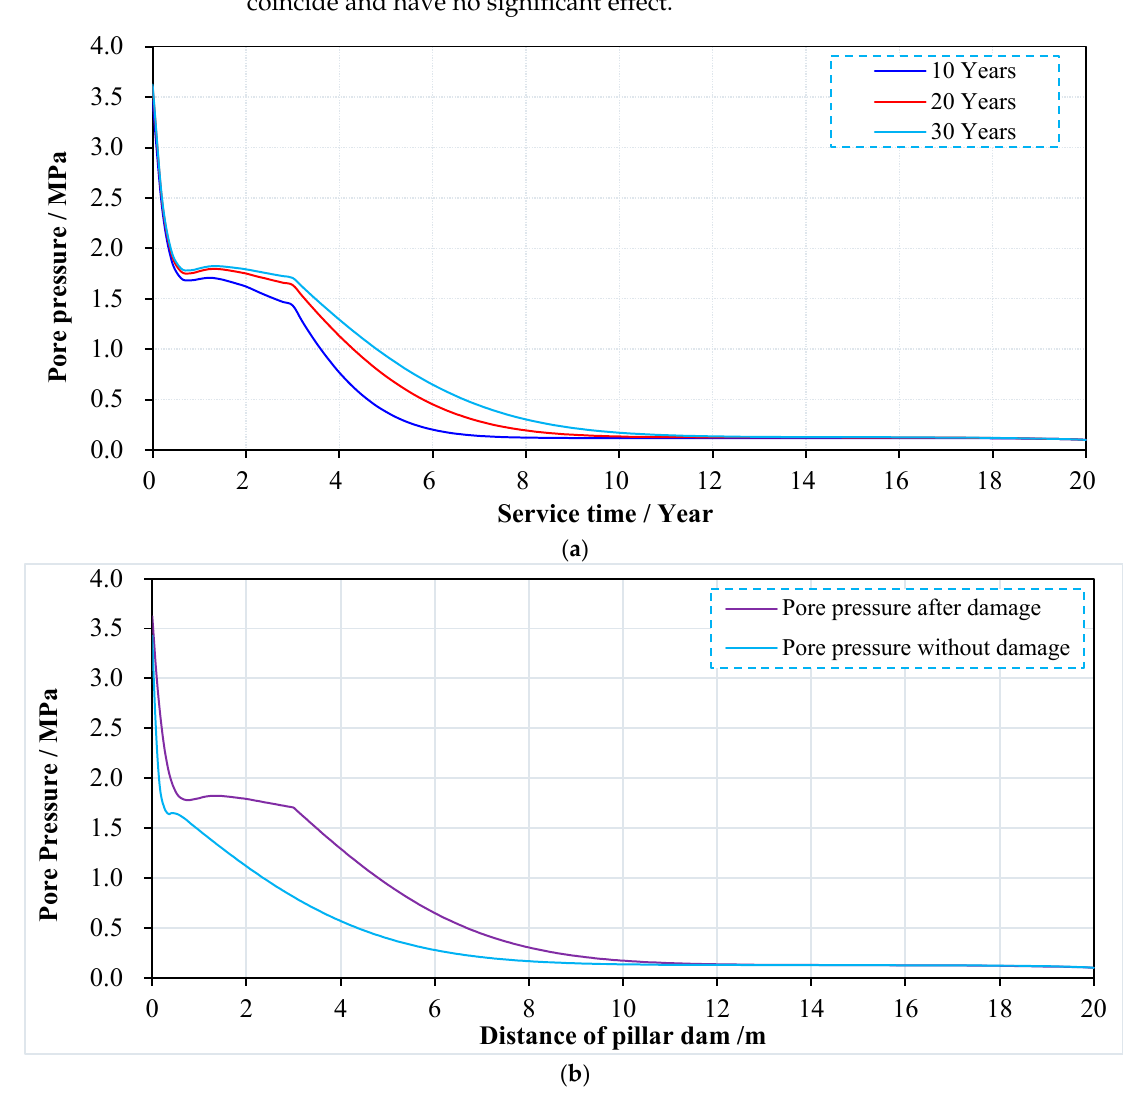
Figure 15. Distribution of pore pressure in the coal pillar dam. ( a ) pore pressure distribution of the coal pillar dam with damaged zones at different times; ( b ) comparison of pore pressure distribution of the damaged and undamaged coal pillar dam.